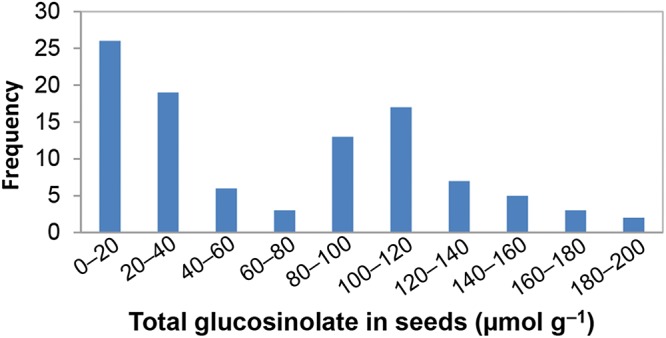
Frequency distribution of total seed glucosinolate concentrations in the diversity panel.